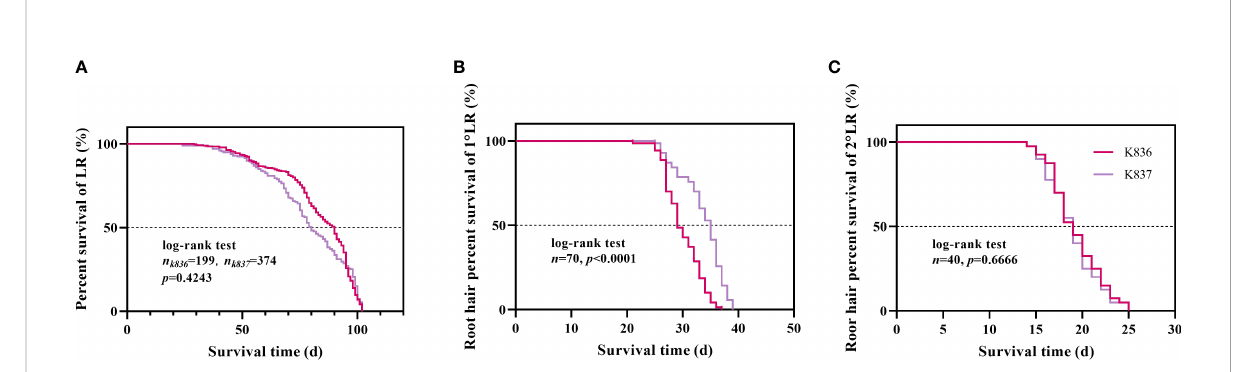
FIGURE 10 Survival analysis of lateral roots and root hair. (A) Lateral roots. (B) Root hair of the primary lateral roots. (C) Root hair of the secondary lateral roots.